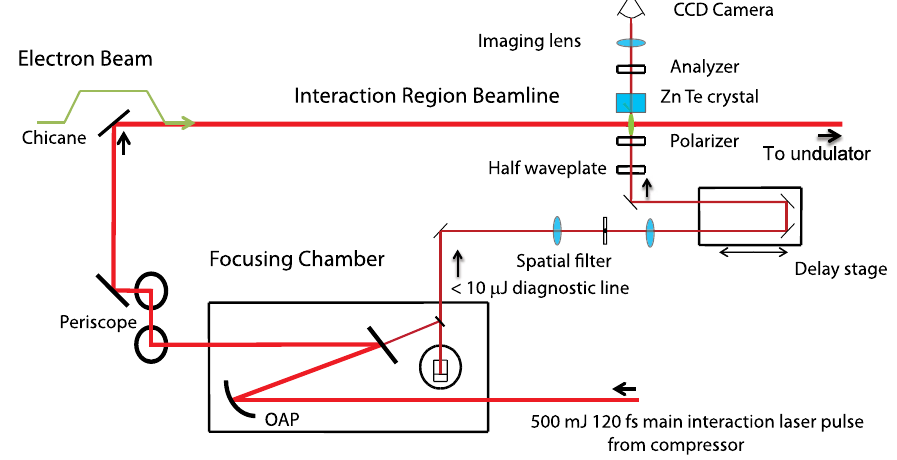
FIG. 6. Diagram of interaction region with details of electro-optic sampling timing